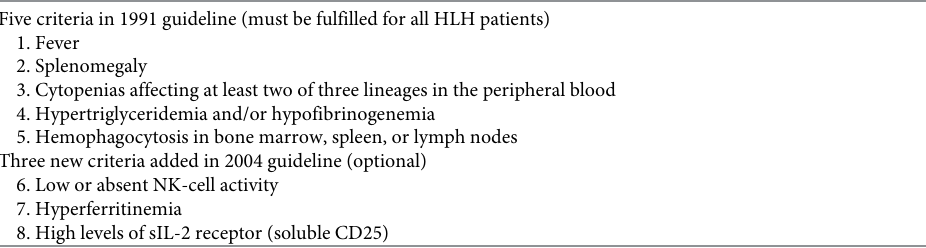
Table 1. Diagnostic guidelines for HLH (HLH-2004 criteria) [15]. Five criteria in 1991 guideline (must be fulfilled for all HLH patients) 1.